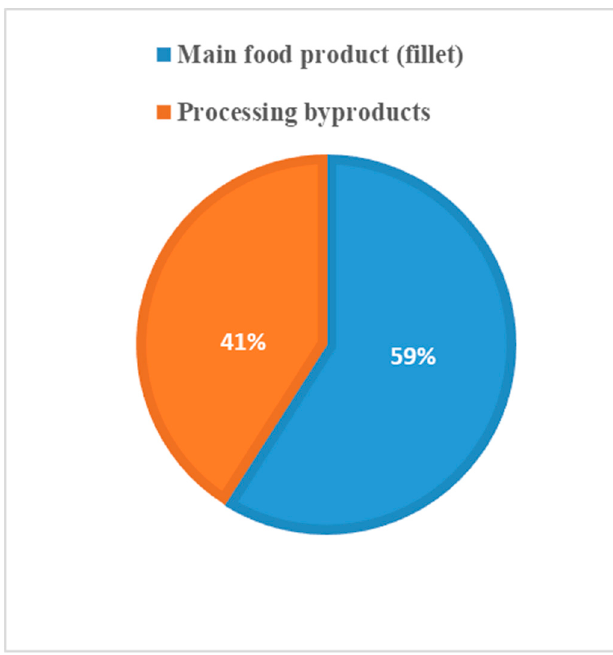
Figure 4. Post-harvest protein distribution.